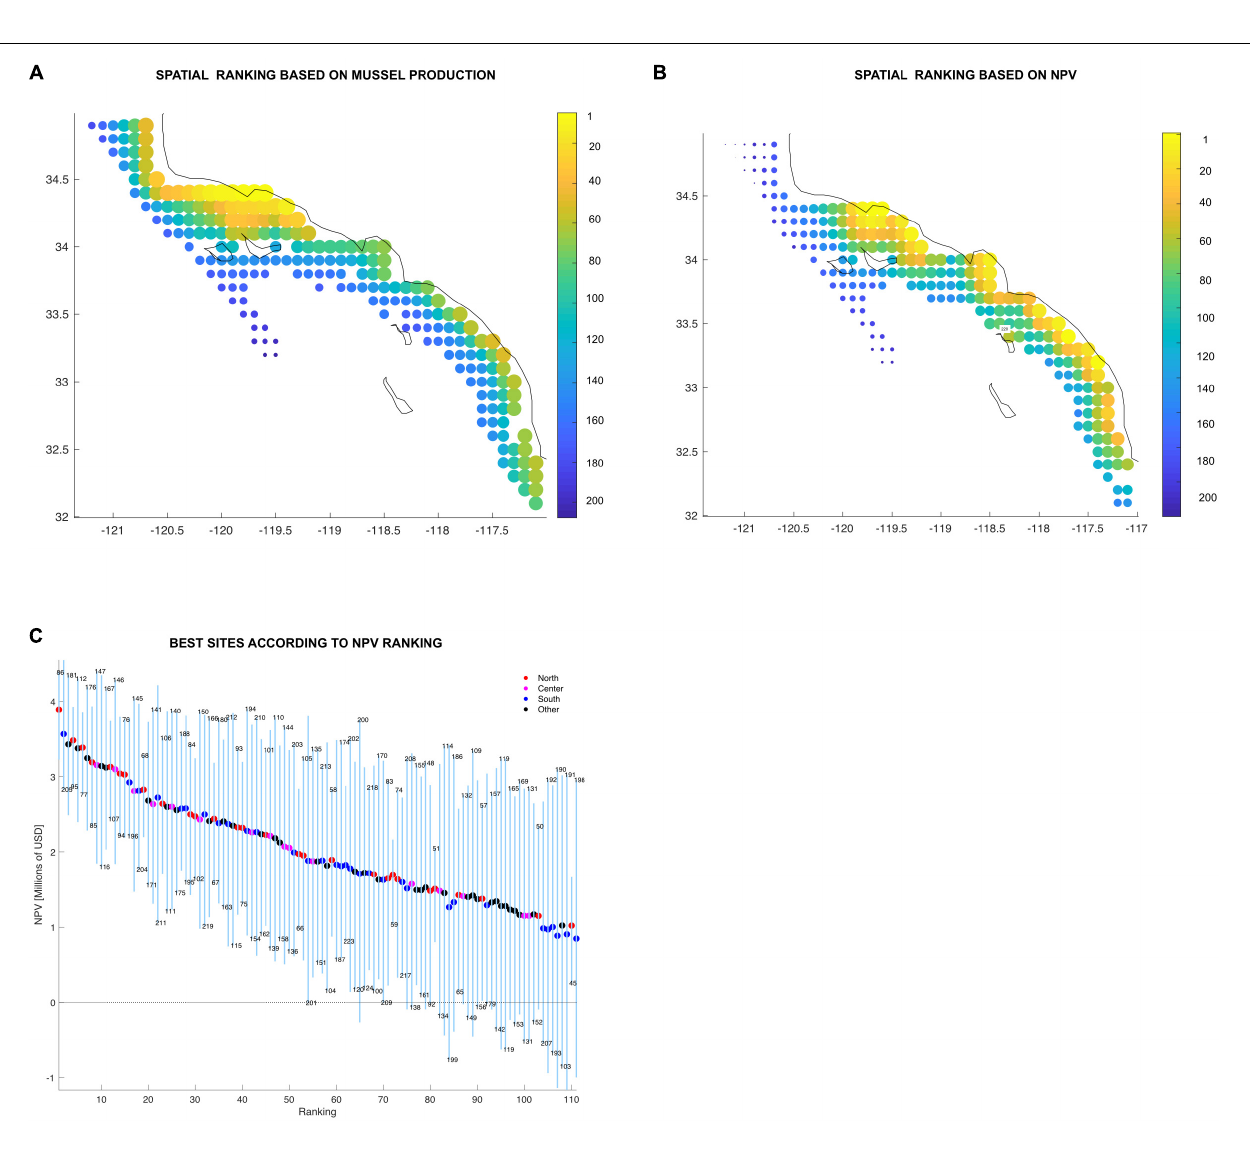
FIGURE 8 | (A,B) Individual ranking displayed spatially showing top sites in yellow down to bad sites in dark blue. Color bar and the size of the marker indicates the site rank. (C) Farm sites above the mean organized from best to worst displaying the minimum and maximum (blue vertical lines) and average (colored dots) values in million USD ( Y -axis). The X -axis shows the ranking order, where sites organized from best to worst. Sites are represented by each of the blue vertical lines and the color on the average dot represent the region where the site is located. The numbers above and below the vertical lines are the site identification numbers. Legend shows the number of sites in each region and the proportion of total